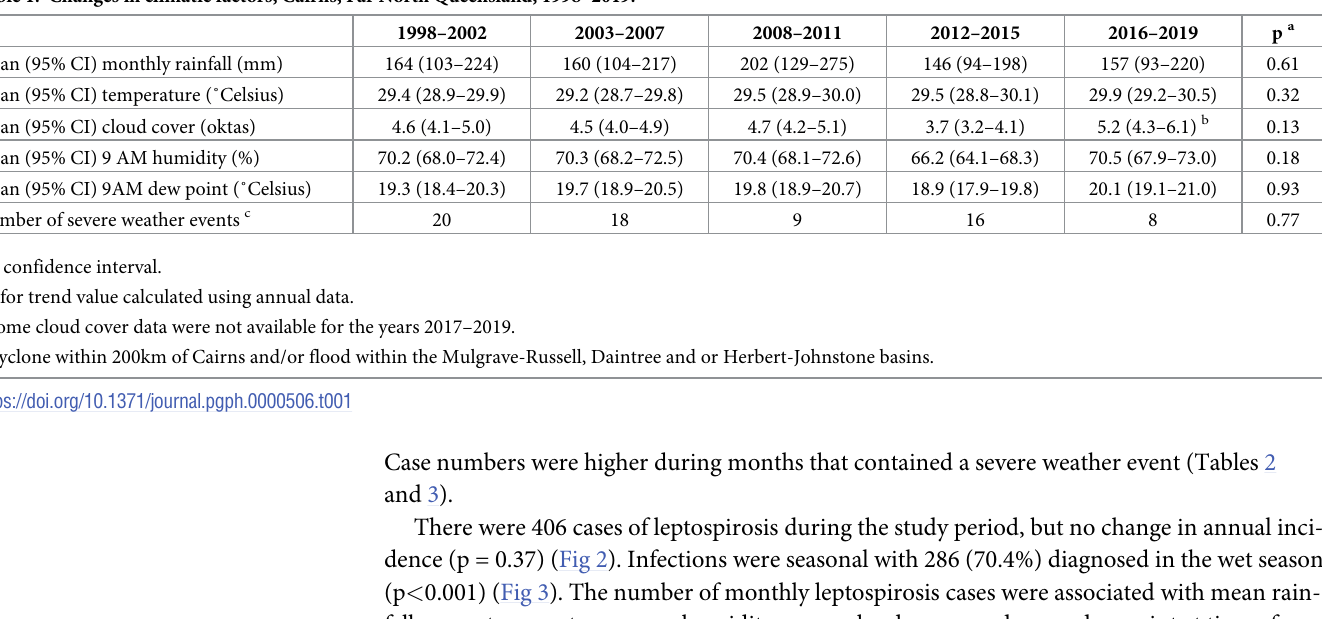
Table 1. Changes in climatic factors, Cairns, Far North Queensland,